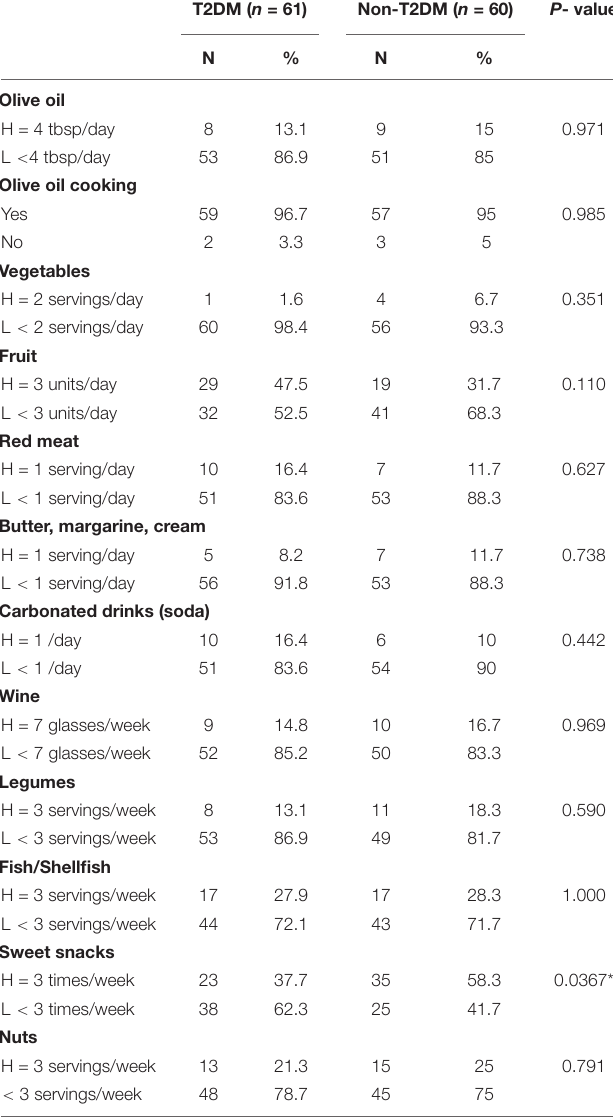
TABLE 1 | Summary of the characteristics of the participant cohort and comparison of participants with and without T2DM. Characteristics